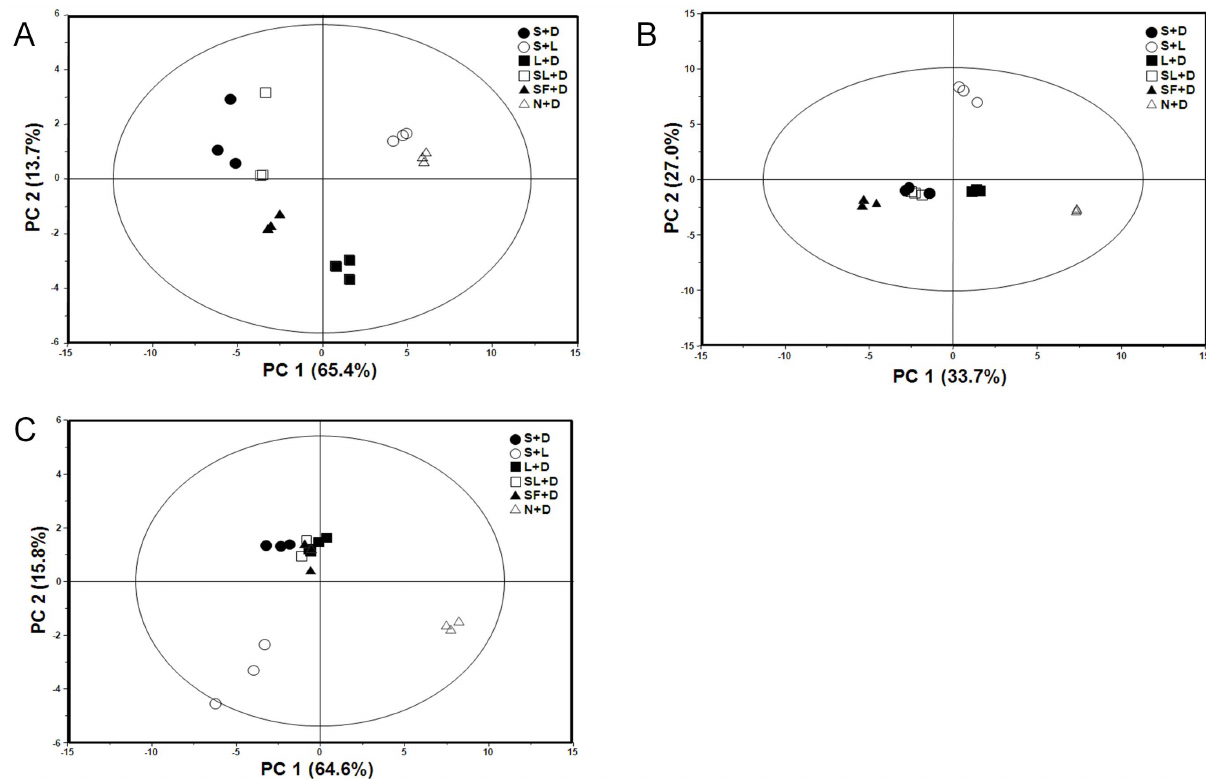
Figure 3. PCA score plots of C.pruinosa mycelia cultivated under various conditions. (A) D 2 O extracts characterized using NMR analysis. (B) 70% methanol extracts and (C) 100% n -hexane extracts characterized using GC-MS analysis. PCA, Principal component analysis.